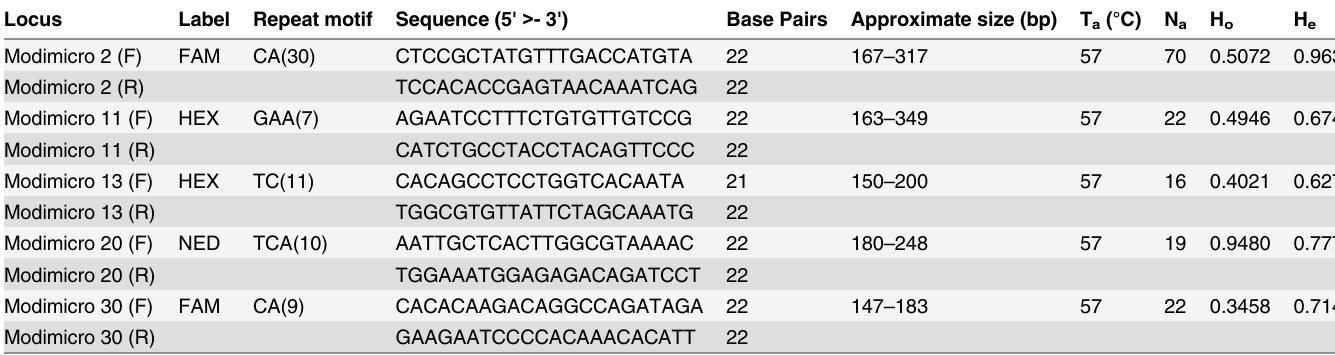
Table 2. Characterisation of microsatellite loci in Modiolus modiolus . Locus Label Repeat motif Sequence (5' > -